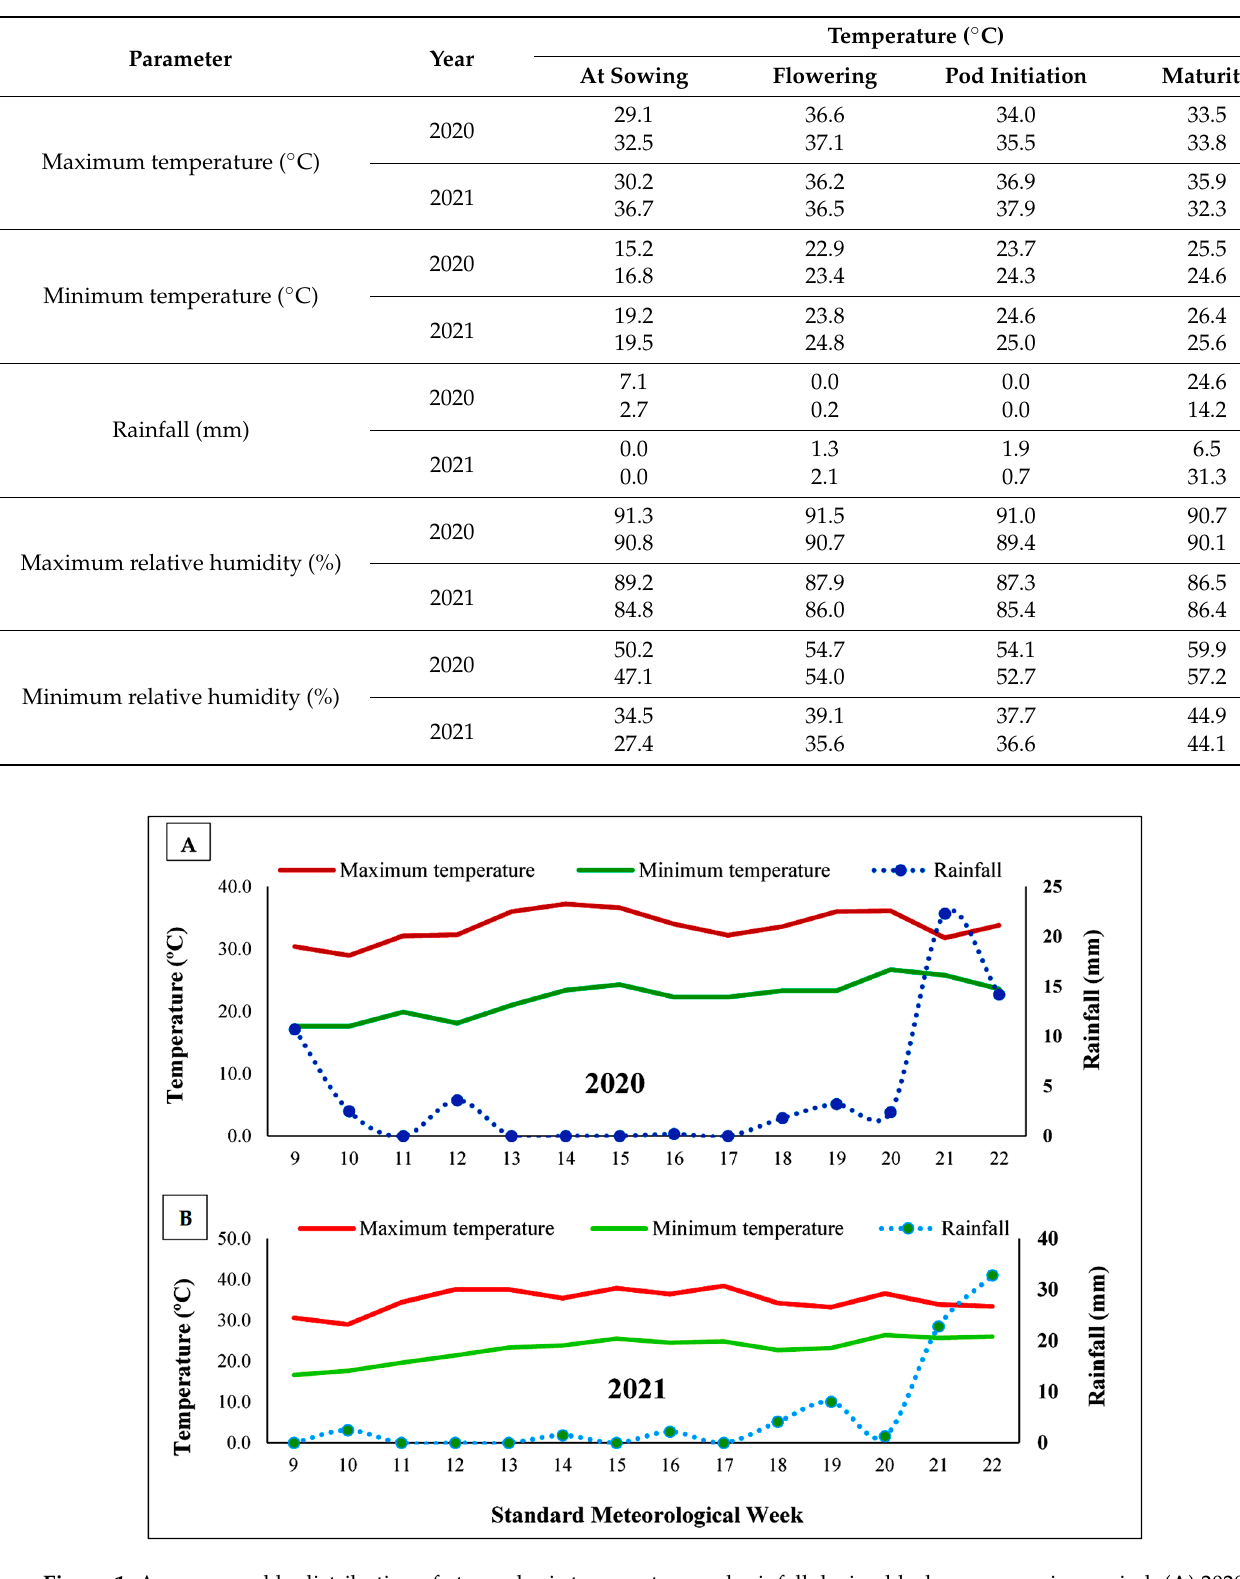
Figure 1. Average weekly distribution of atmospheric temperature and rainfall during black gram growing period: ( A ) 2020 and ( B ) 2021.